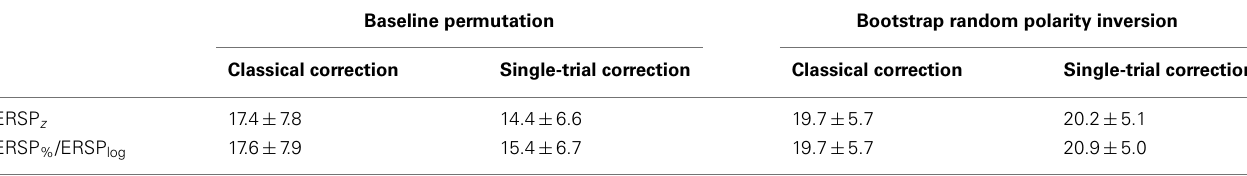
Table 2 | Mean percentage of significant time–frequency points (pixels) for different ERSP methods for electrode Iz. Baseline